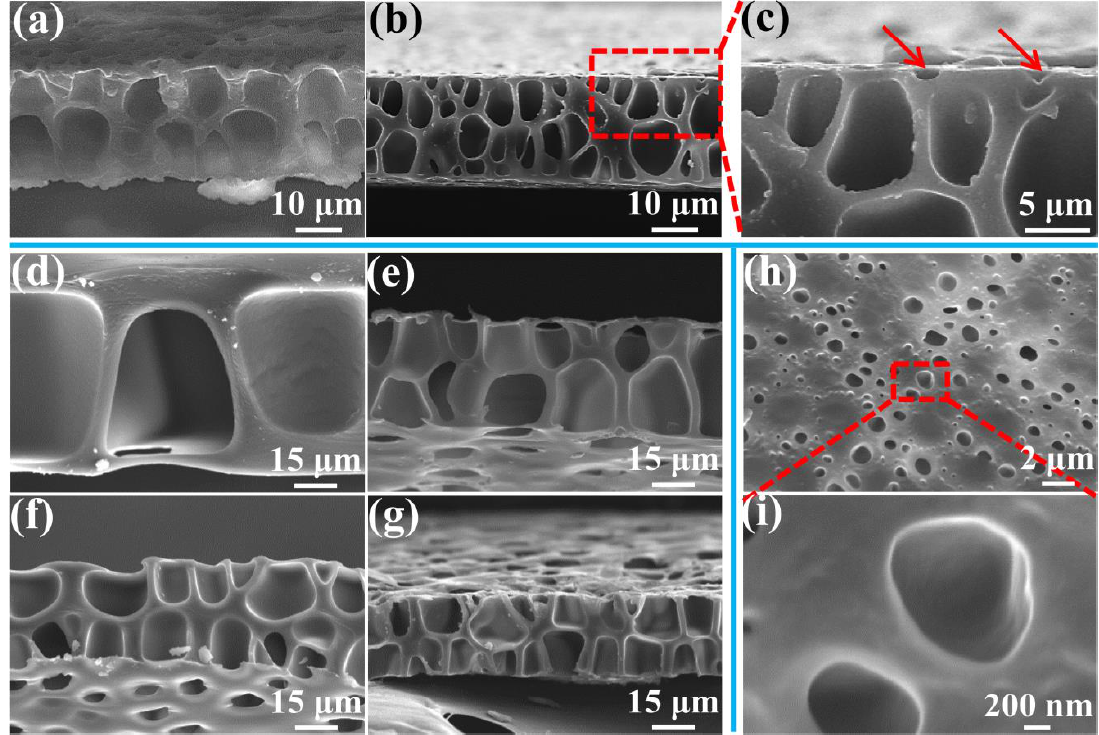
Figure 7. SEM images of the cross-section of the membrane with various thicknesses prepared under different saturation pressure and foaming temperature conditions: ( a ) 21 μm, 3.5 MPa, and di ff erent saturation pressure and foaming temperature conditions: ( a ) 21 µ m, 3.5 MPa, and 120 ◦ C; 120  C; ( b – c ) 23 μm, 4.0 MPa, and 120  C; ( d ) 70 μm, 1.5 MPa, and 130  C; ( e ) 39 μm, 2.0 MPa, and ( b – c ) 23 µ m, 4.0 MPa, and 120 ◦ C; ( d ) 70 µ m, 1.5 MPa, and 130 ◦ C; ( e ) 39 µ m, 2.0 MPa, and 120 ◦ C; 120  C; ( f ) 34 μm, 2.5 MPa, and 120  C; and ( g ) 28 μm, 3.0 MPa, and 120  C. SEM images of the ( f ) 34 µ m, 2.5 MPa, and 120 ◦ C; and ( g ) 28 µ m, 3.0 MPa, and 120 ◦ C. SEM images of the surface of the surface of the membrane ( h , i ), obtained under 4.5 MPa saturation pressure and 120  C foaming membrane ( h , i ), obtained under 4.5 MPa saturation pressure and 120 ◦ C foaming temperature.